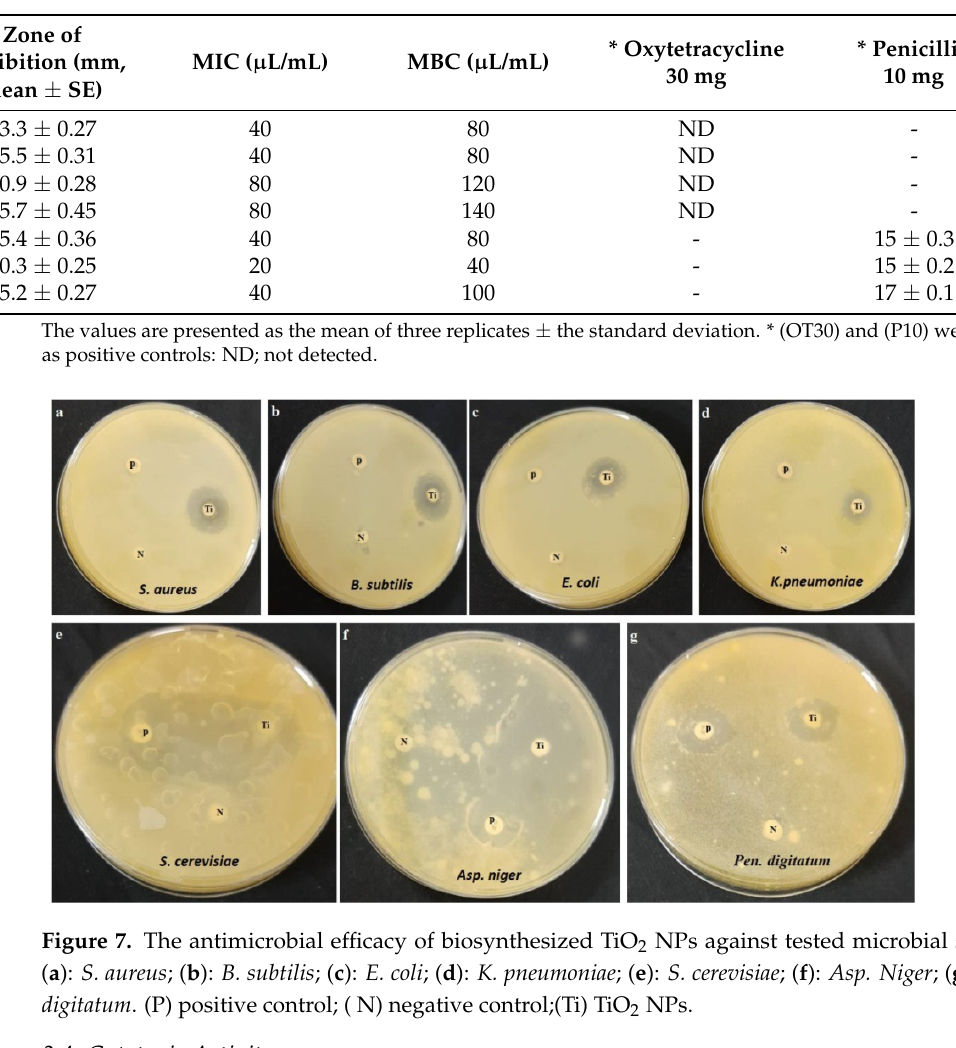
Table 2. Antimicrobial efficacy of TiO 2 NPs analyzed by disc diffusion technique, minimal inhibition concentration (MIC), and minimum bactericidal concentration (MBC).